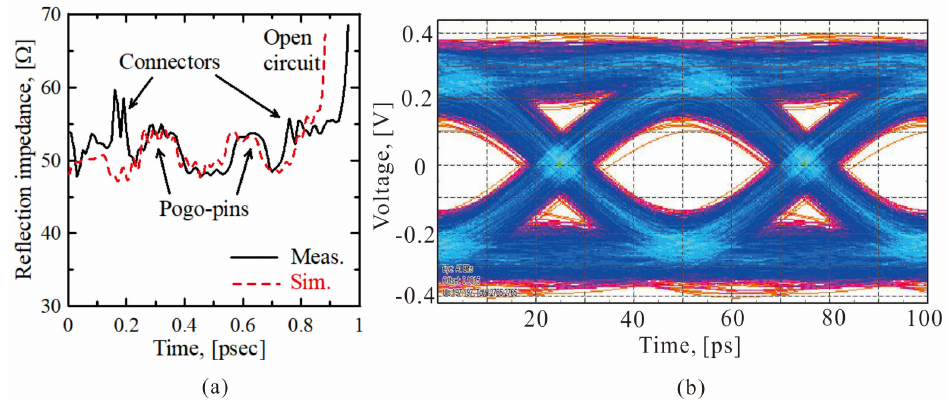
Figure 6. ( a ) TDR waveform converted from S-parameters and ( b ) measured eye diagram for 20 Gbps OOK